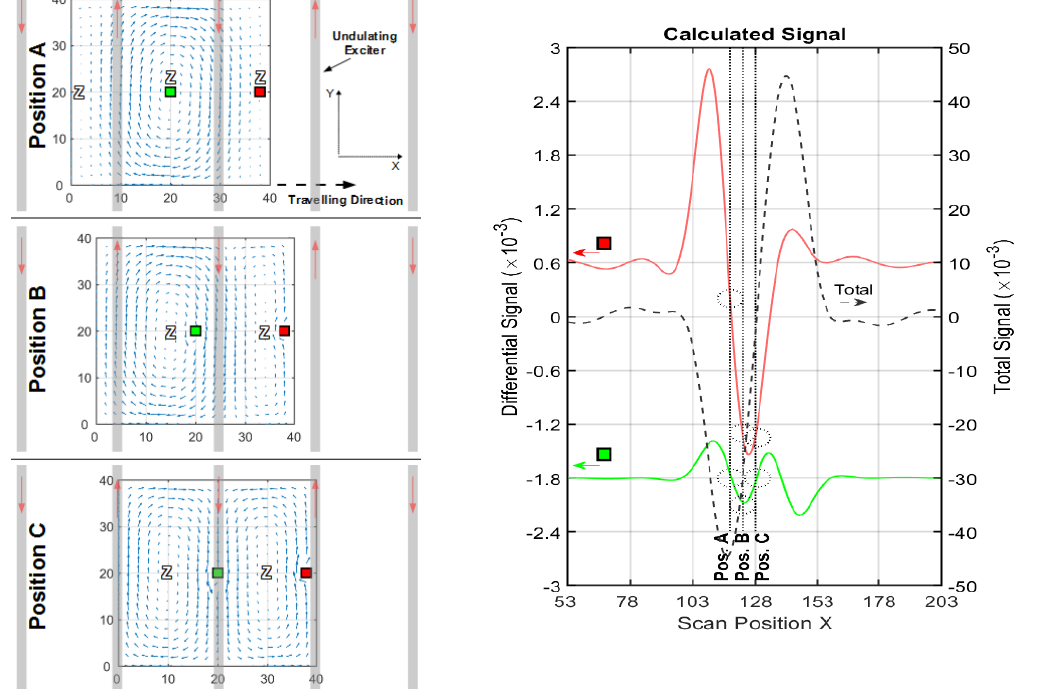
Figure A7. Current and signal calculations with an undulator exciter and a circular receiver; (left) Travelling 2D sheet with local voids (green and red) in front of an undulator. Blue arrows depict the current direction and intensity. Only three significant x-positions (A, B and C) are shown; (right) Total (dotted black) and differential signals for a void in the center (green) and for a void at the edge (red). Table A2. The main results from the calculated signals, shown in Figure A7. Total Signal (max.